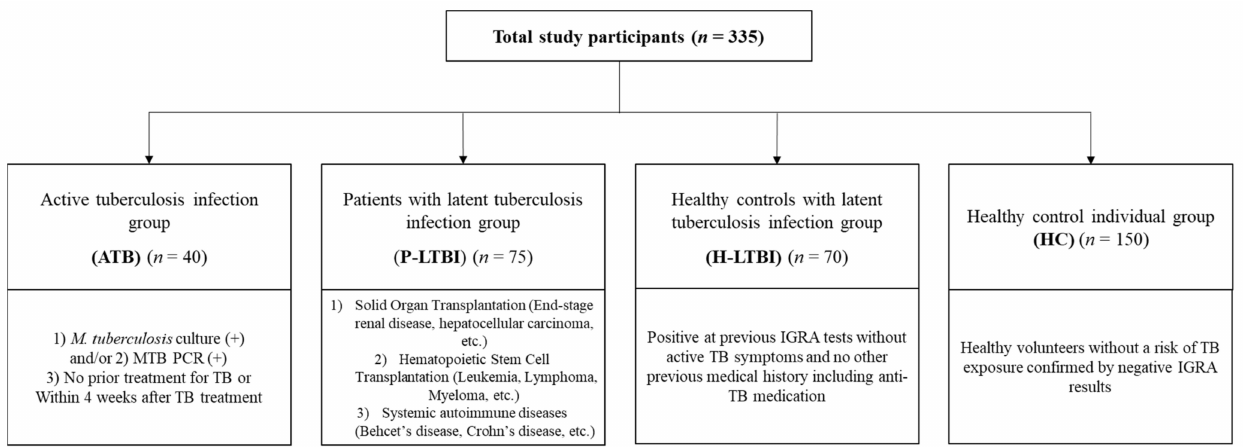
Figure 1. Study group and inclusion criteria. Four groups were included; ATB, patients diagnosed active tuberculosis; P-LTBI, patients with immunosuppressive status diagnosed latent tuberculosis infection; H-LTBI, Healthy controls with diagnosed latent tuberculosis infection; HC, healthy control individuals with minimal risk to tuberculosis (TB) exposure.